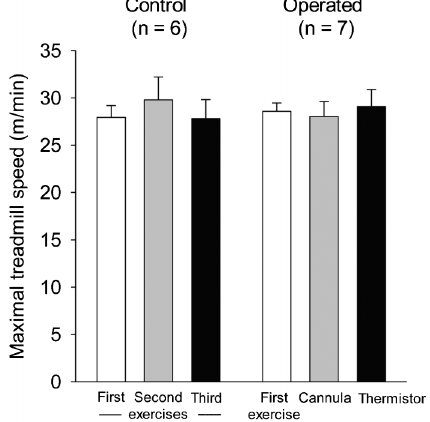
Figure 4. Lines showing the contours of brain lesions caused by the implantation of a guide cannula and insertion of a thermistor are drawn in coronal cortical sections taken from the Paxinos and Watson atlas (16). The numbers above the schematic of each cortical section indicate the distance (in mm) between the section plane and bregma.